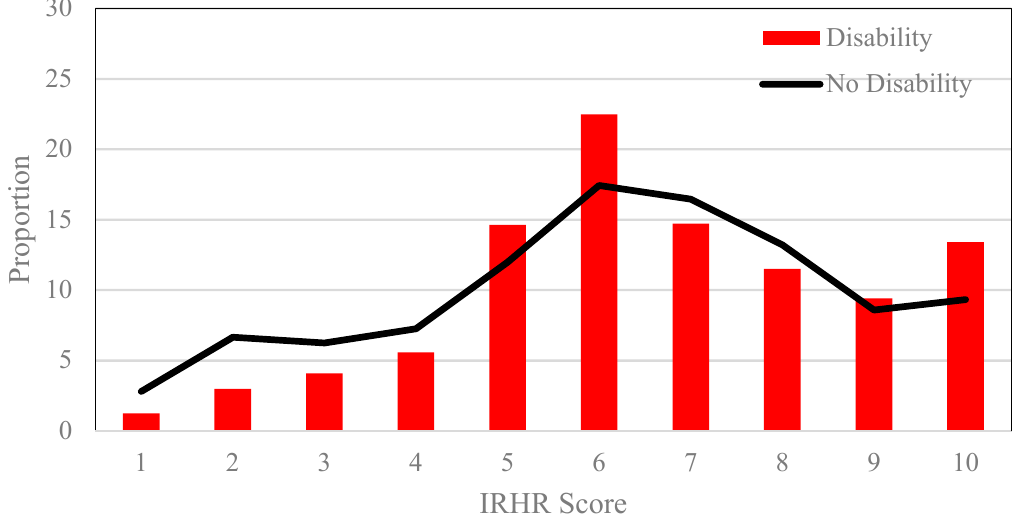
Figure 1. Index of Relative Homelessness Risk by all disability and long-term conditions versus no impairment (post-National Disability Insurance Scheme